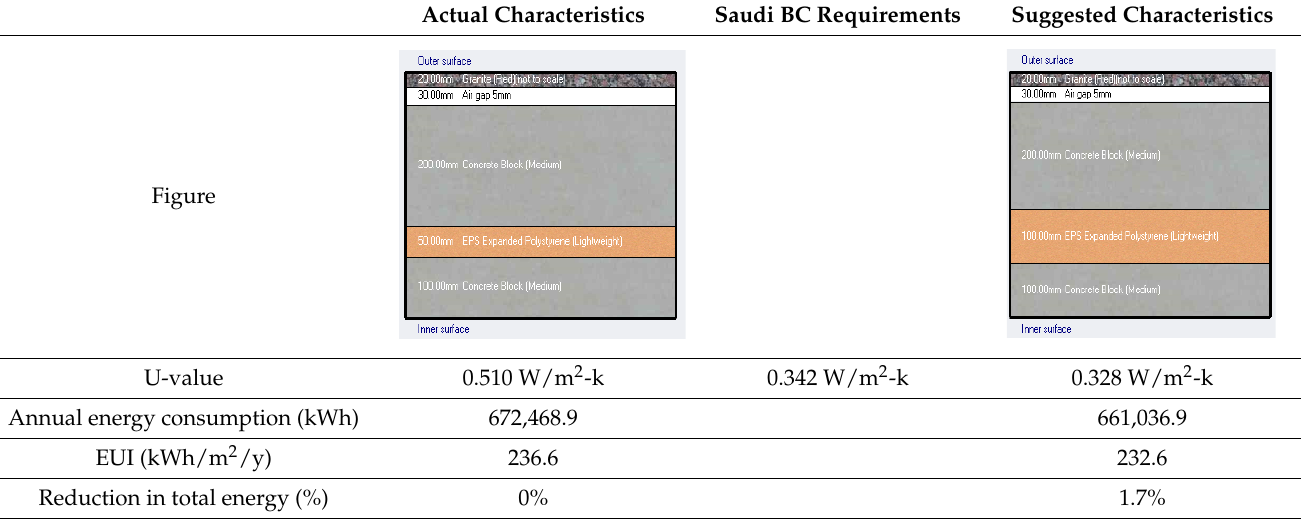
Table 6. Difference in wall lyres between the actual materials and the suggested materials.